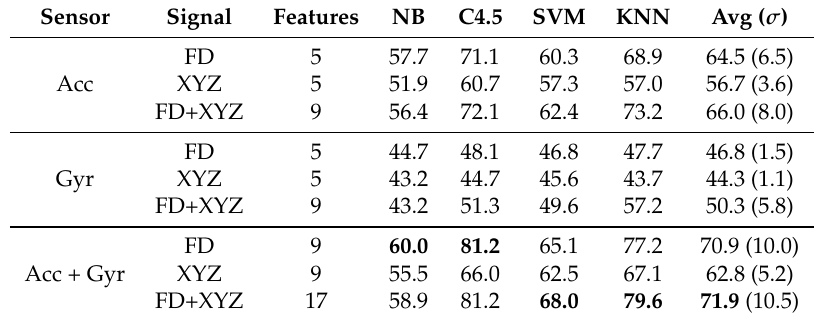
Table 5. Correctly classified instances (%) using augmented data, number of instances = 49,325. Sensor Signal Features